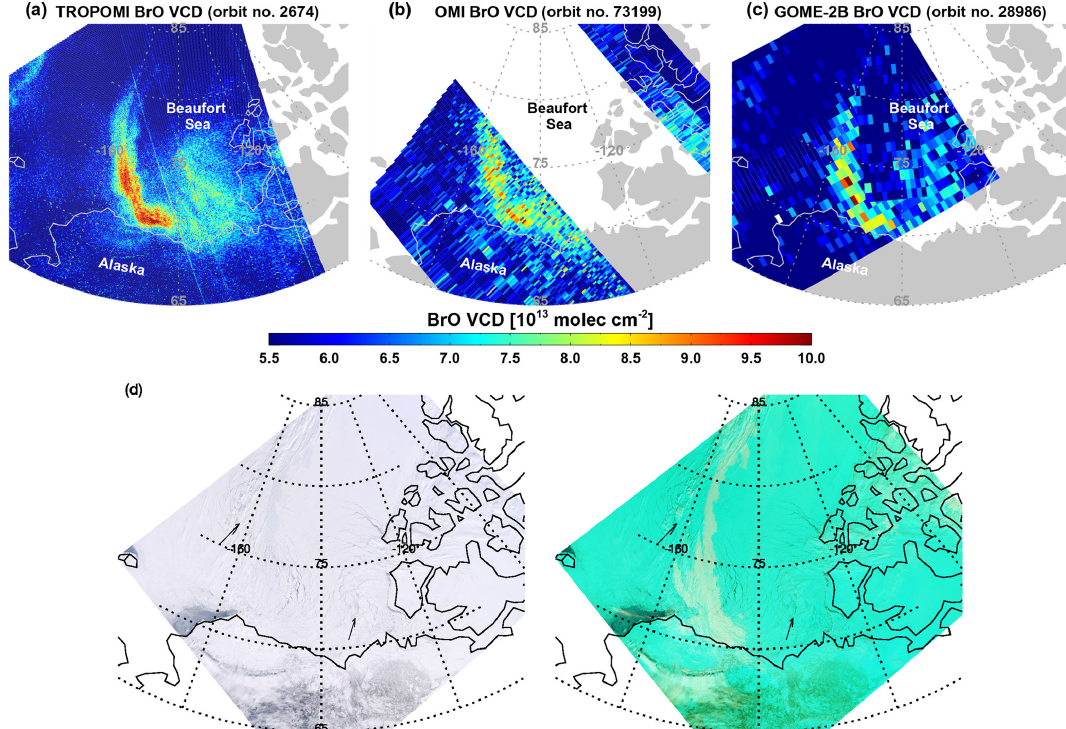
Figure 14. BrO geometric vertical columns observed over the Arctic sea ice region on 19 April 2018 from (a) TROPOMI, (b) OMI, and (c) GOME-2B. (d) MODIS true color image (left) and image using combinations of 7-2-1 bands (right) from the Aqua satellite for the same scene on the same day. Leads are slightly darker in the MODIS image as indicated by the